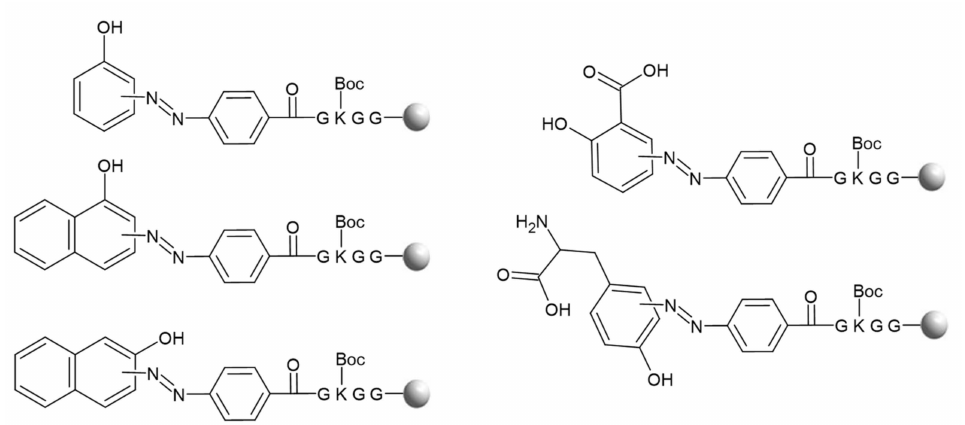
Figure 7. Structures of azo derivatives obtained during the synthesis on a solid